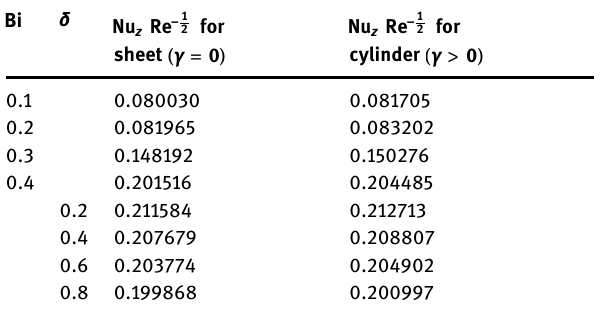
Table 2: E ff ects of Bi and δ on Nu Re z − 1 2 for γ 0 = and γ 0 > Bi